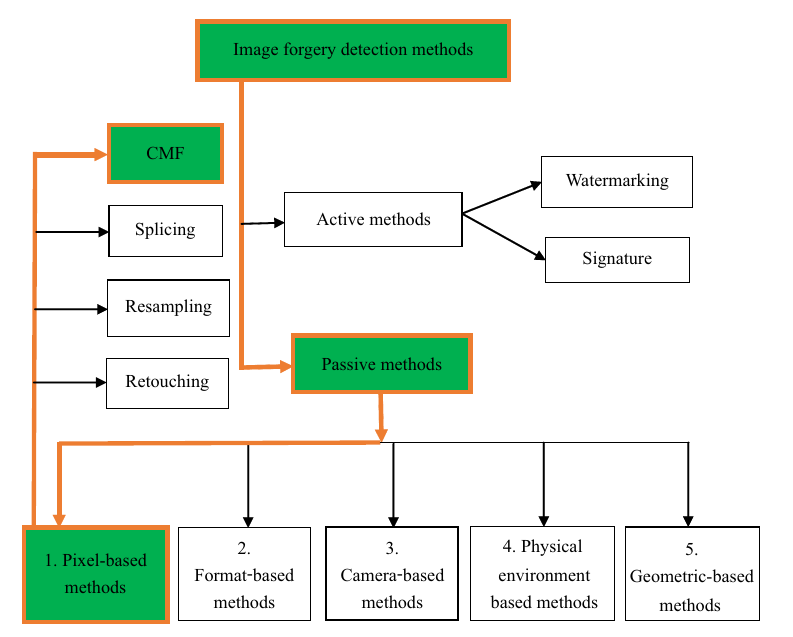
Fig. 1 Various image forgery detection